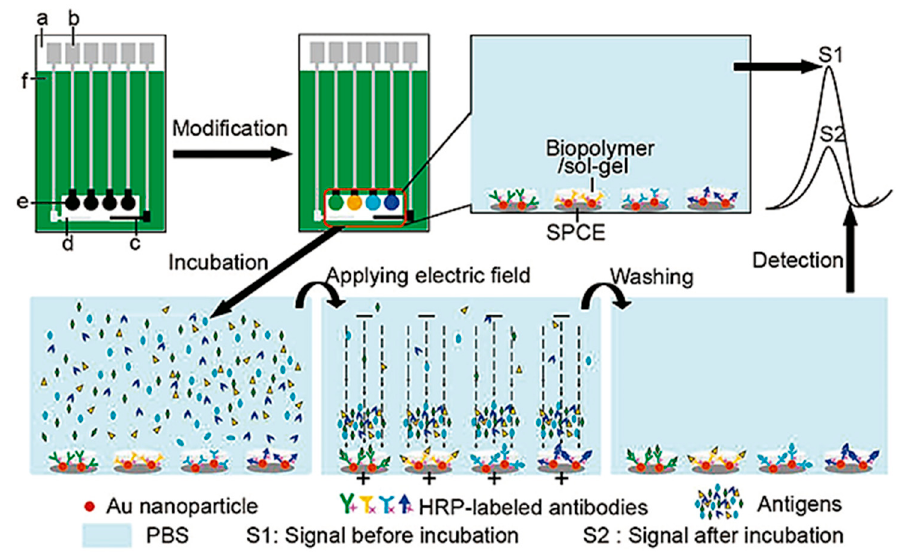
Figure 7. Schematic representation of an electrochemical multiplexed immunoassay with an electric field-driven incubation process. (a) nylon sheet; (b) silver ink; (c) graphite auxiliary electrode; (d) Ag/AgCl reference electrode; (e) graphite working electrode; and (f) insulating dielectric. Adapted from [112].